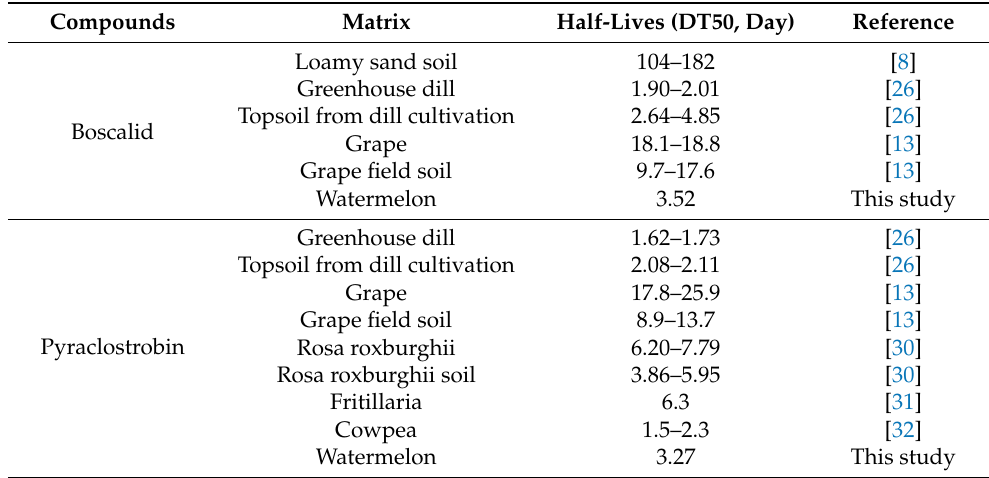
Table 4. Comparison of half-lives of boscalid and pyraclostrobin in different matrices.